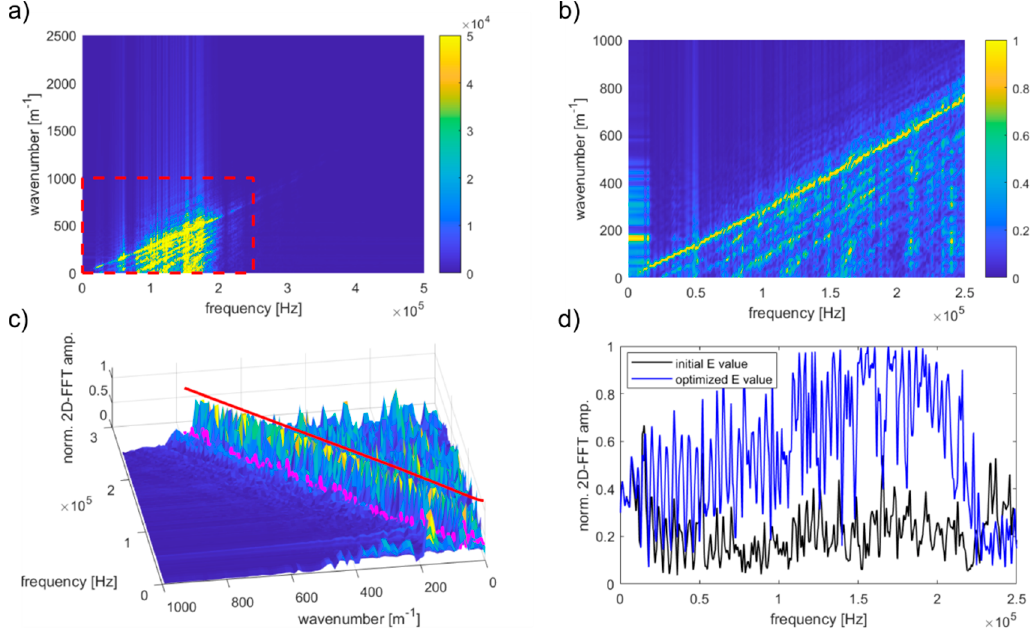
Figure 11. The Young modulus determining algorithm: ( a ) The 2D-FFT map and the data area selected for further analysis; ( b ) results of the normalization; ( c ) visualization of 2D-FFT interpolation along the dispersion curve; ( d ) comparison of interpolation results for a pre-selected and finally appointed Young modulus values.